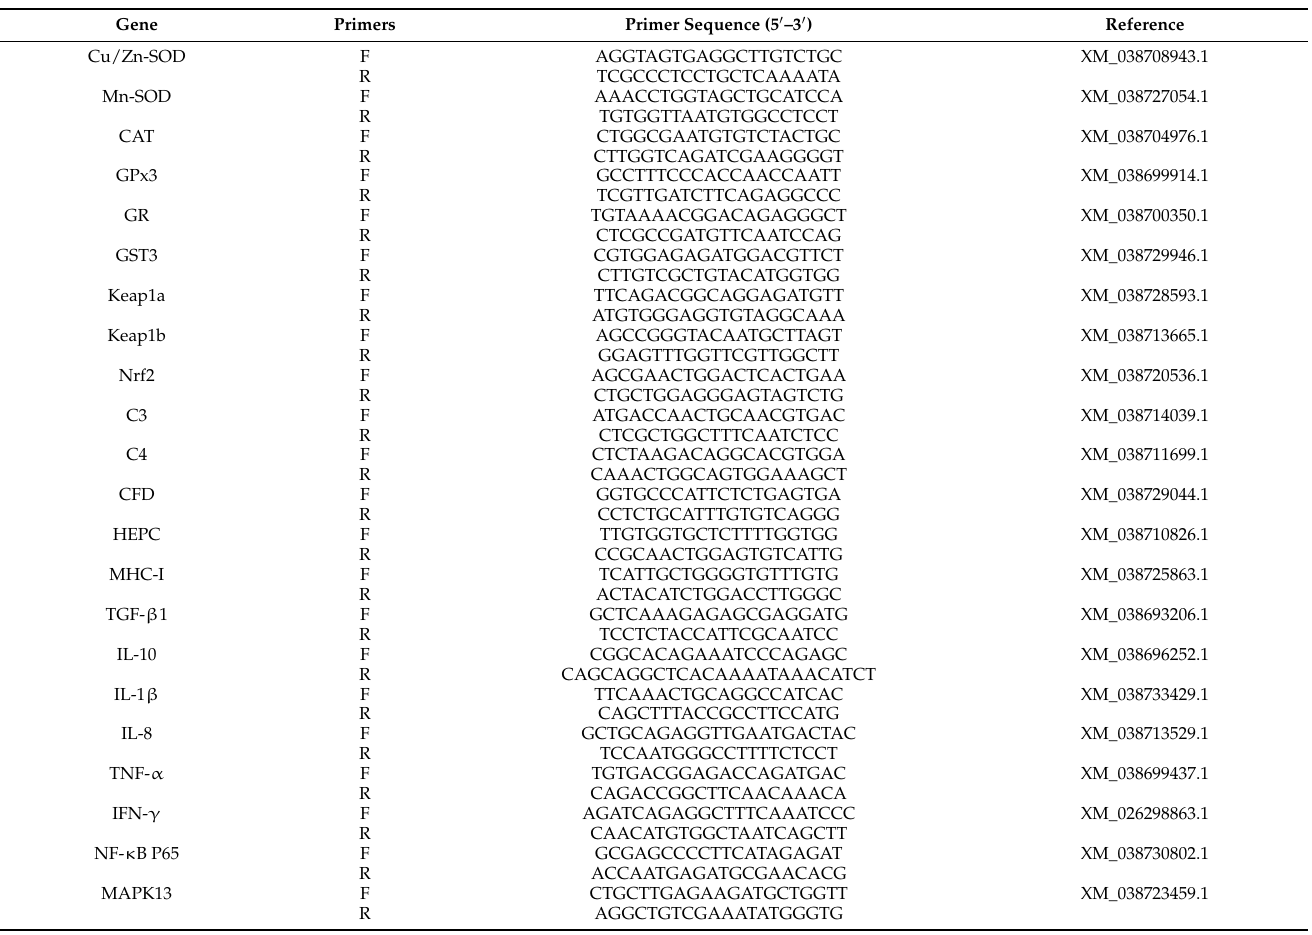
Table 2. Primer sequences for real-time PCR